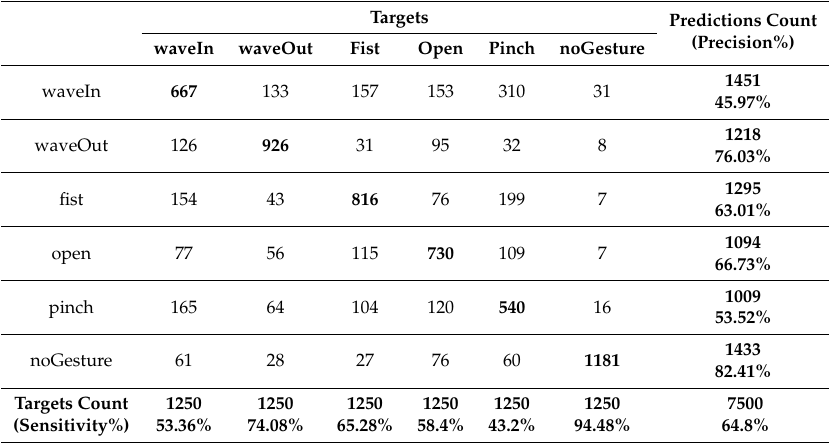
Table A4. Confusion matrix of first sync gesture for the user-general HGR model.